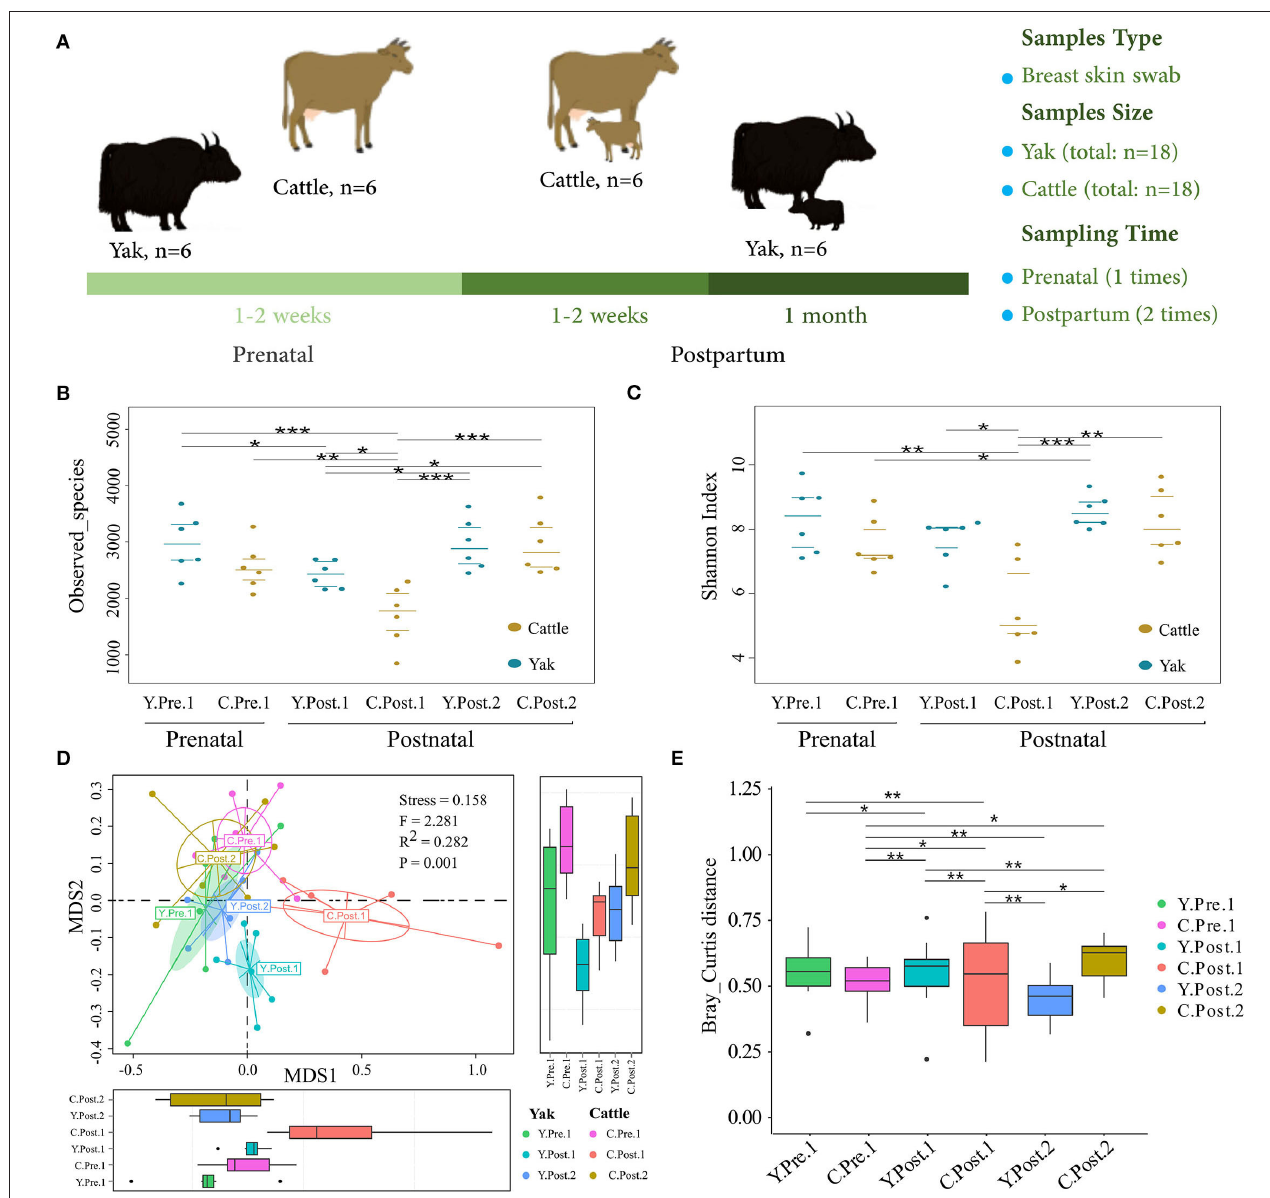
FIGURE 1 | Abundance and diversity of udder skin microbiota of yak and cattle during the perinatal period. (A) Experimental design, including sample collection time, sample type, and sample number. The diversity and richness of microbial communities in the udder skin of yak and cattle in different periods during the perinatal period were analyzed. The observed species richness (B) and Shannon Diversity Index (C) are shown by beeswarm plots. (D) Based on Bray_Curtis distance, NMDS maps of the microbial community in the udder skin of yak and cattle were drawn, and the udder skin microbiota in different periods during the perinatal period were examined by PERMANOVA. (E) The box plots were used to show the differences in the microbial communities in the udder skin of yak and cattle during different periods of the perinatal period. The difference between two groups was considered statistically significant when the p -value was < 0.05 (* p < 0.05; ** p < 0.01; *** p <